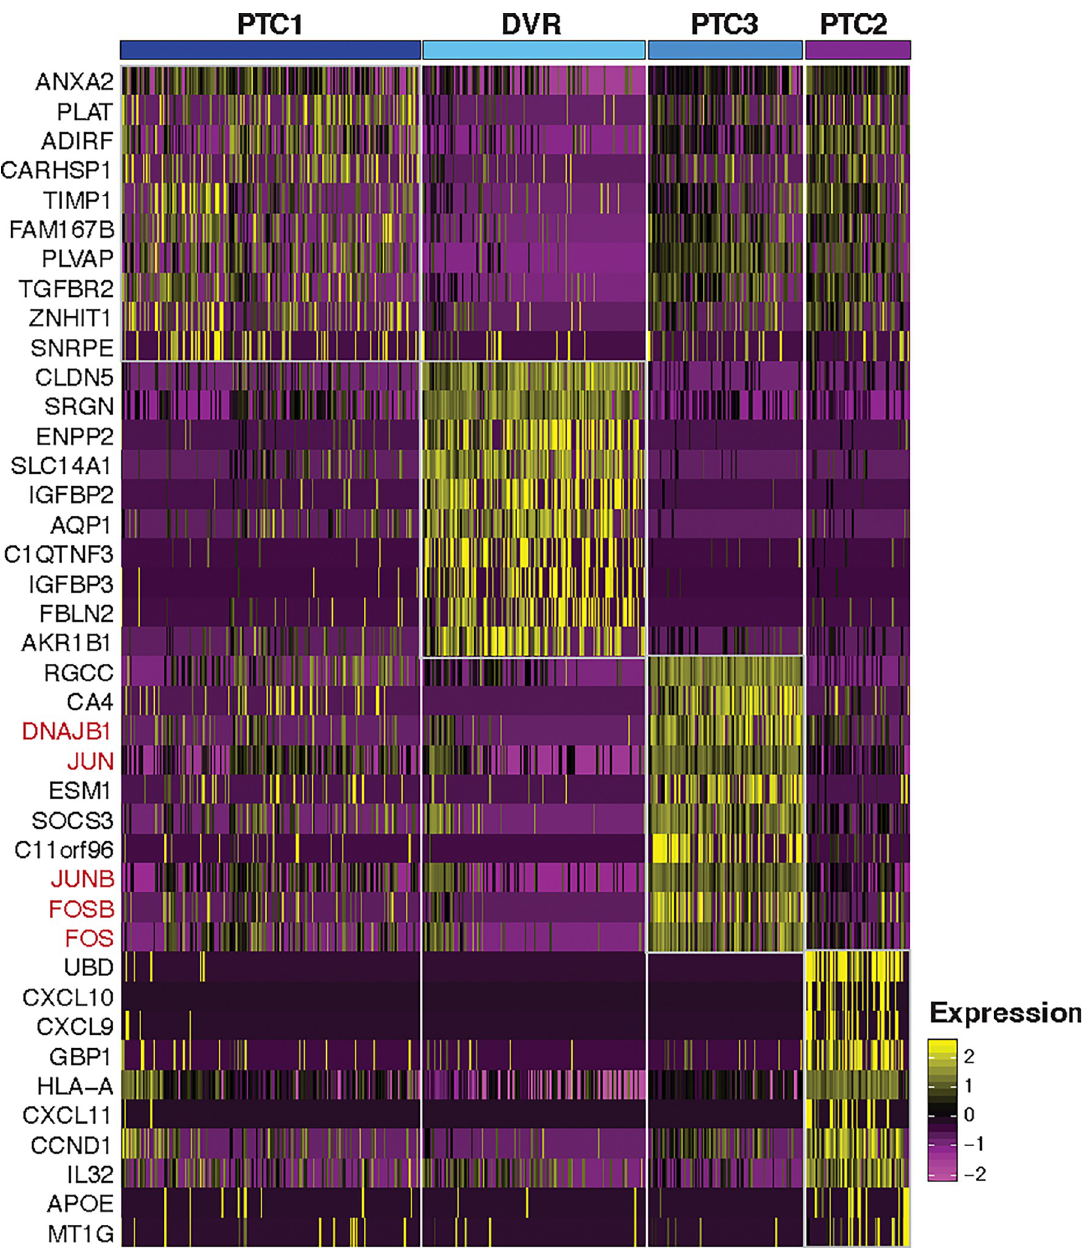
Fig 13. Differential gene expression in endothelial cell subtypes. Figure depicts heatmap of the differentially expressed genes in the endothelial cell subtypes. were differentiated from the non-migratory FB4 subpopulation by S100A4 expression in the migratory FBs. Interstitial fibroblasts appear after gastrulation because of EMT from secondary epithelium [49]. Calcium-binding protein S100A4 —also called FSP1—likely plays an impor- tant role in facilitating and maintaining EMT phenotype [50]. S100A4 is also expressed in some endosteal lining cells and marrow stromal cells and may be an EMT niche for osteogenic precursor cells, indifferent endosteum, fibroblasts, and marrow stromal cells [50]. Addition- ally, S100A4 promotes metastasis and is associated with intestinal fibroblast migration in